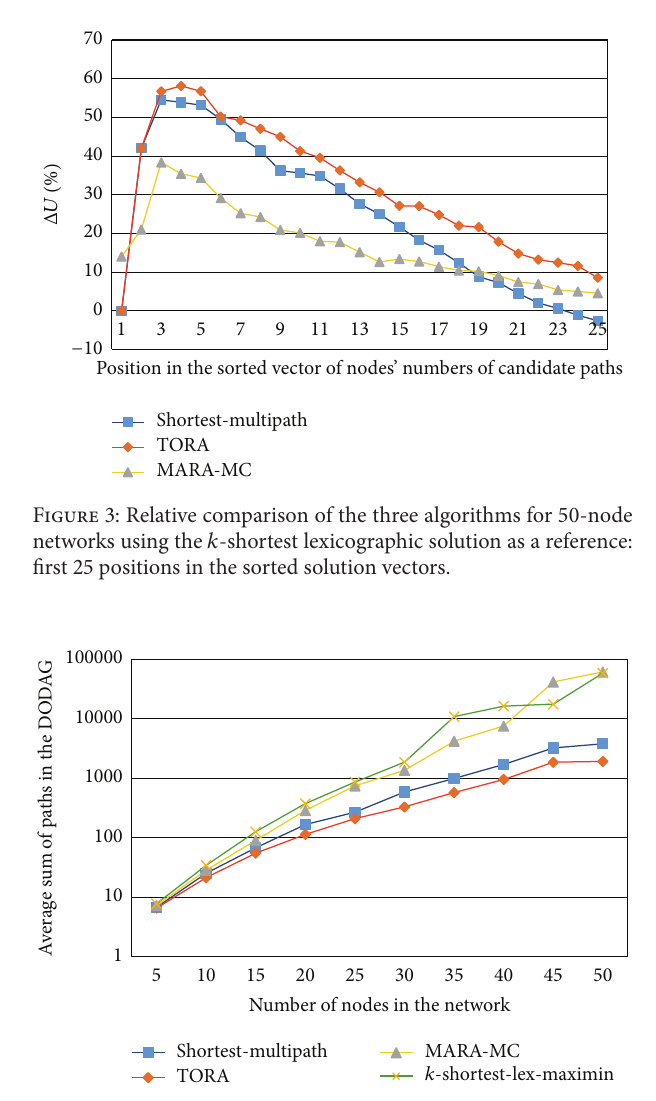
Figure 4: Average sum of all paths in the